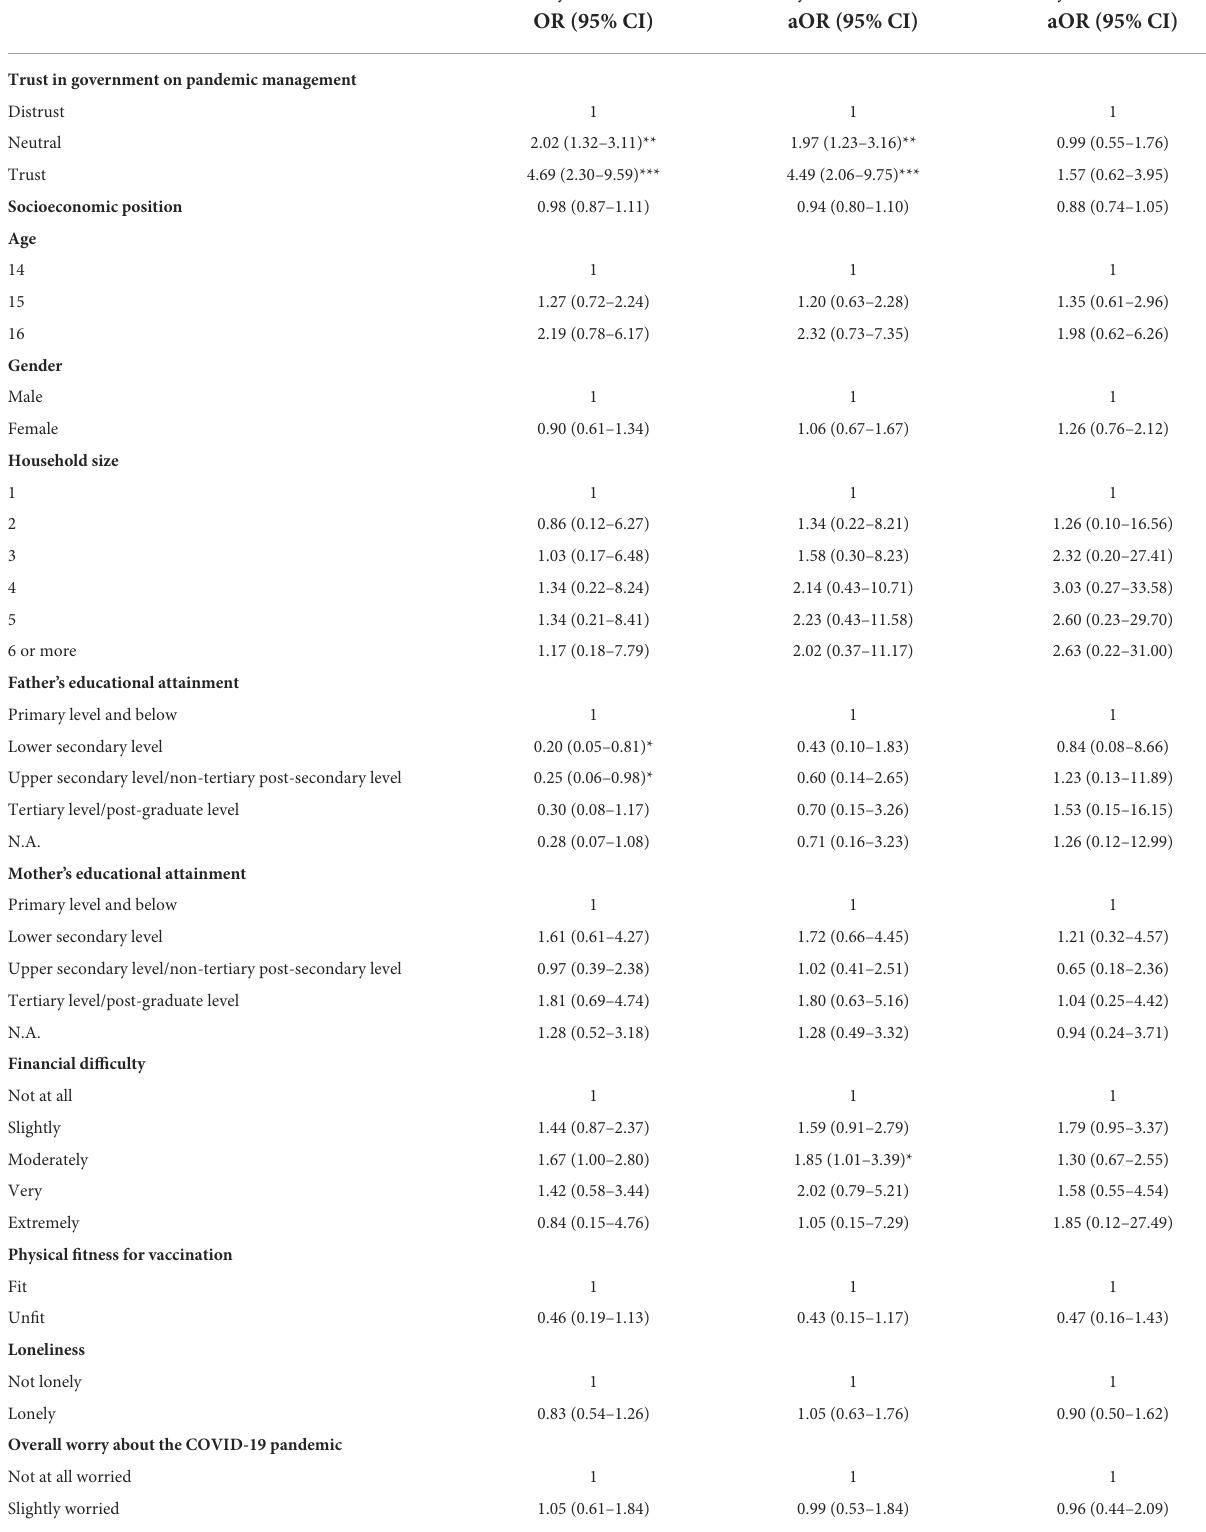
TABLE 4 Multivariable logistic regression on predictors of the intention to receive COVID-19 vaccine among non-vaccinated respondents ( n =